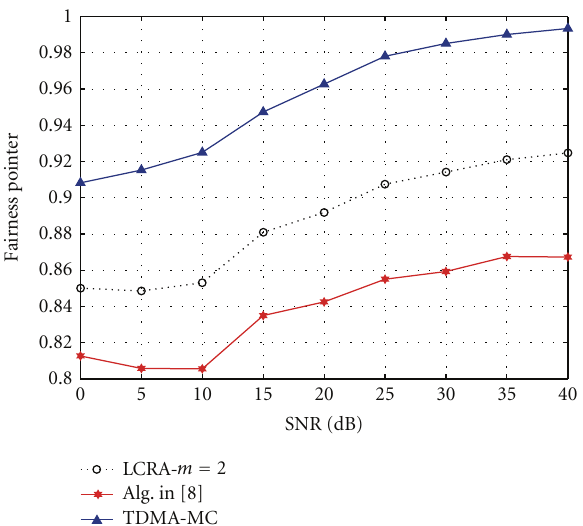
Figure 8: Fairness pointer versus number of MGs.